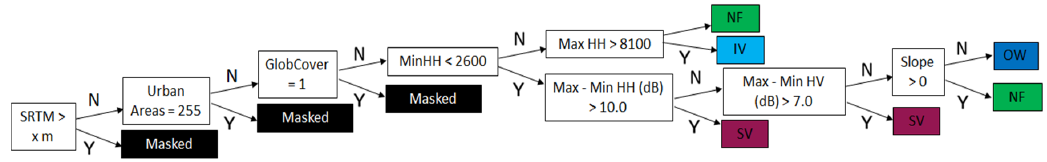
Figure 4. Decision tree applied to derive classification for maximum inundation. IV: inundated vegetation, SV: seasonally submerged vegetation, OW: open water, NF: non-flooded vegetation. The SRTM elevation threshold was adjusted for each sub-basin to account for variations in elevation and topography amongst the sub-basins. Ancillary data on urban areas and land cover were used to mask anthropogenic areas. The elevation and anthropogenic areas are all under the “masked” class. Minimum Inundation Extent Classification